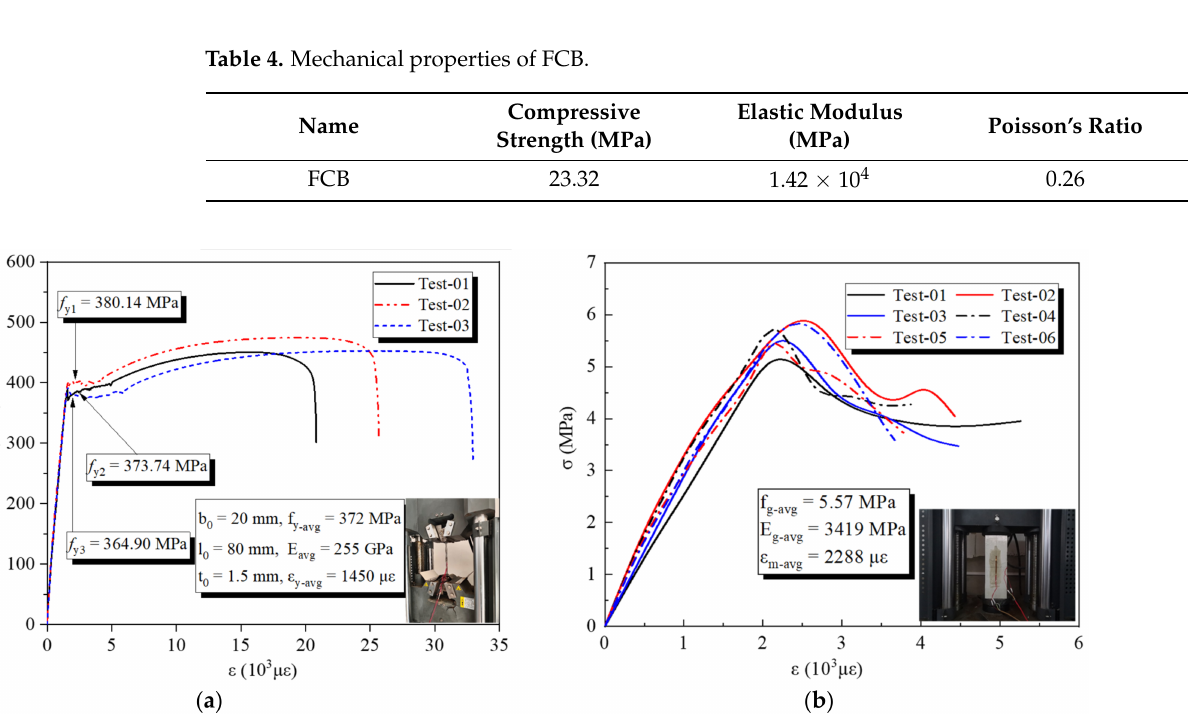
Figure 2. Mechanical properties of steel and PG between studs. ( a ) Stress–strain curves of steel; ( b ) stress–strain curves of PG between